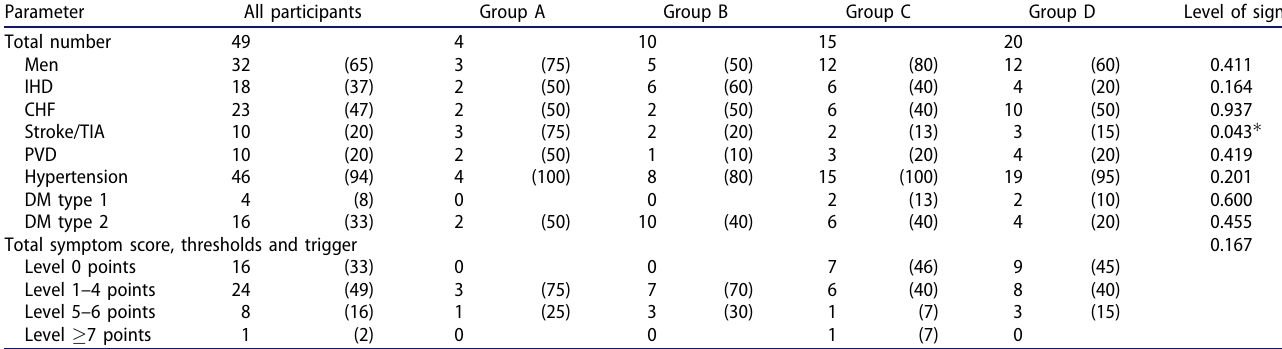
Table 3. Baseline characteristics of all enrolled patients. Parameter All participants